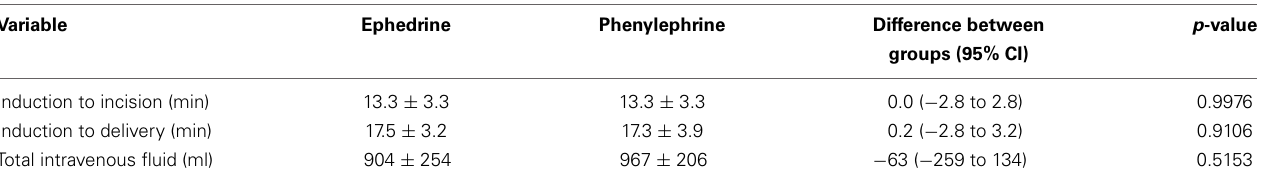
Table 4 | Surgical times and intravenous